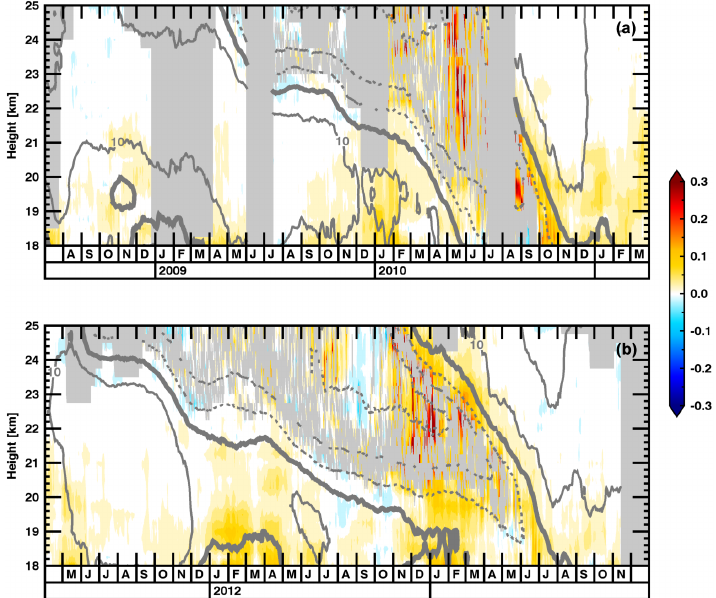
Figure 5. Time series of momentum fluxes from the Manus ARM site, continued. The span here covers 1 July 2008 through 31 Decem- ber